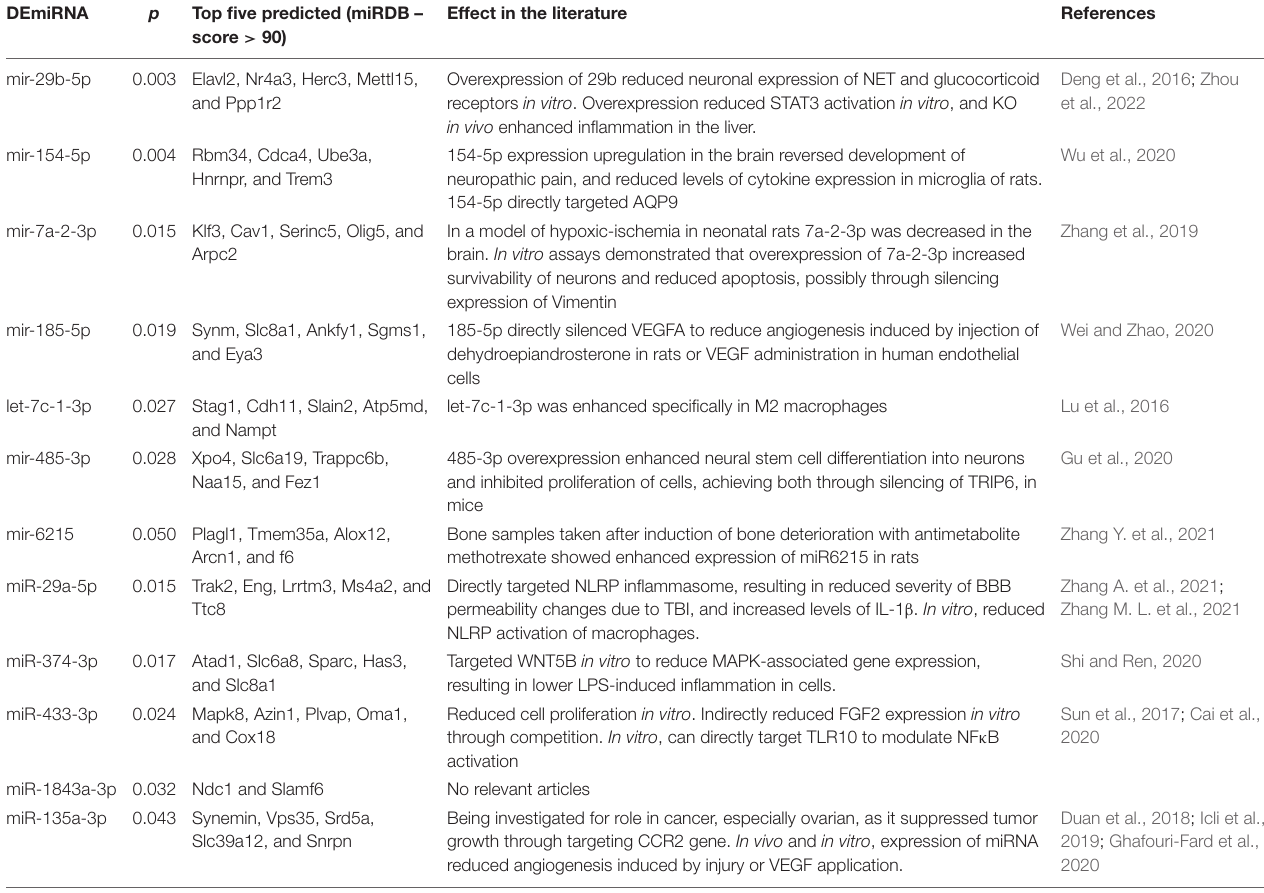
TABLE 2 | Differentially expressed miRNA in Experiment 3, using a raw p -value of < 0.05. DEmiRNA p Top five predicted (miRDB – score >